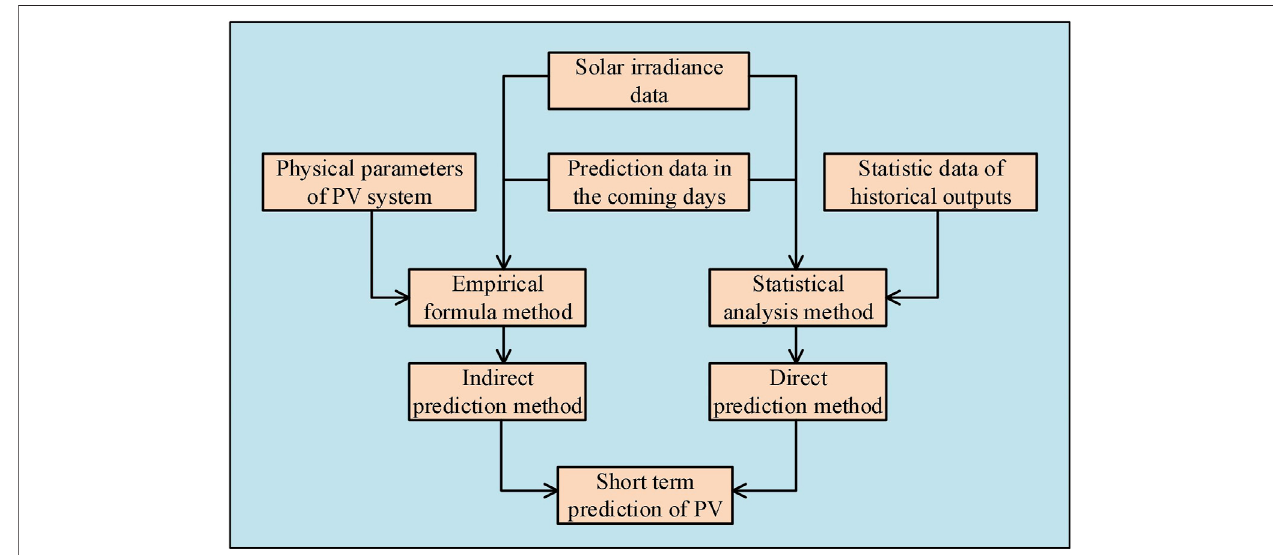
FIGURE 1 | Classi fi cation of short-term PV power prediction